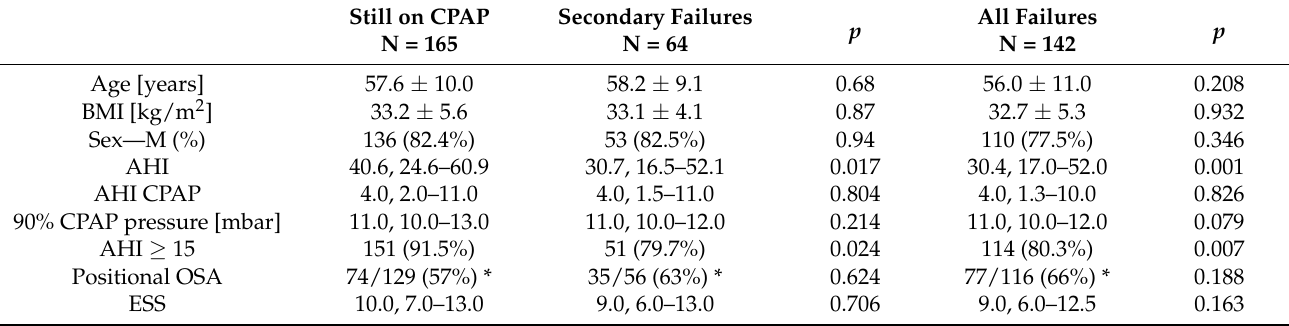
Table 4. Demographic and clinical characteristic of patients still on treatment, secondary failures, and all